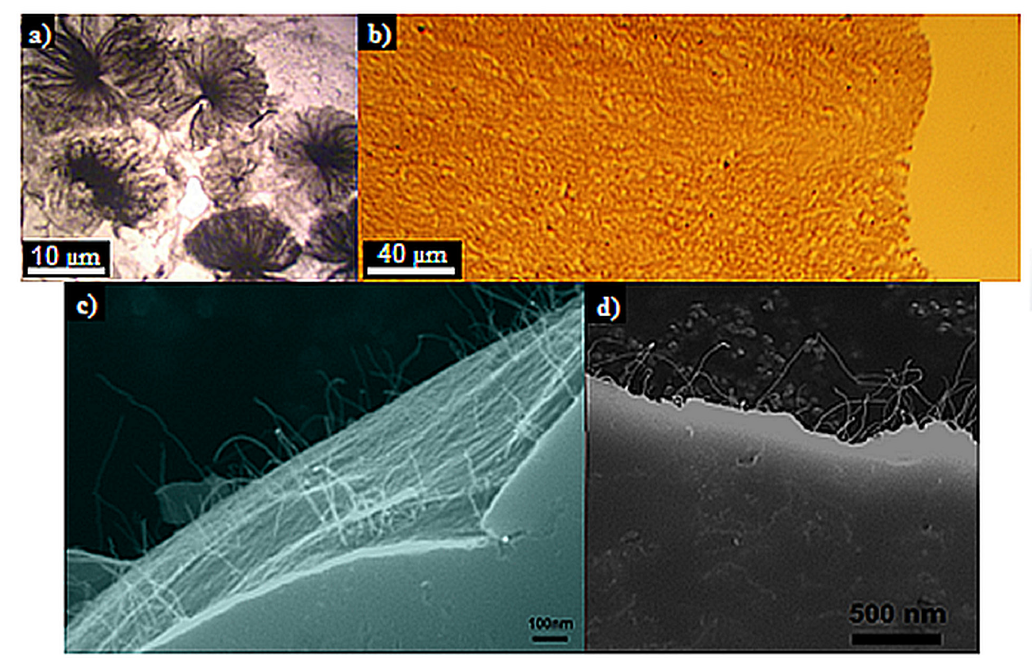
-CNT mixture is pressed between two glass plates; (b) MTICl-Ti(OBu) 4 -CNT ceramic films, single CNTs are shown. 4